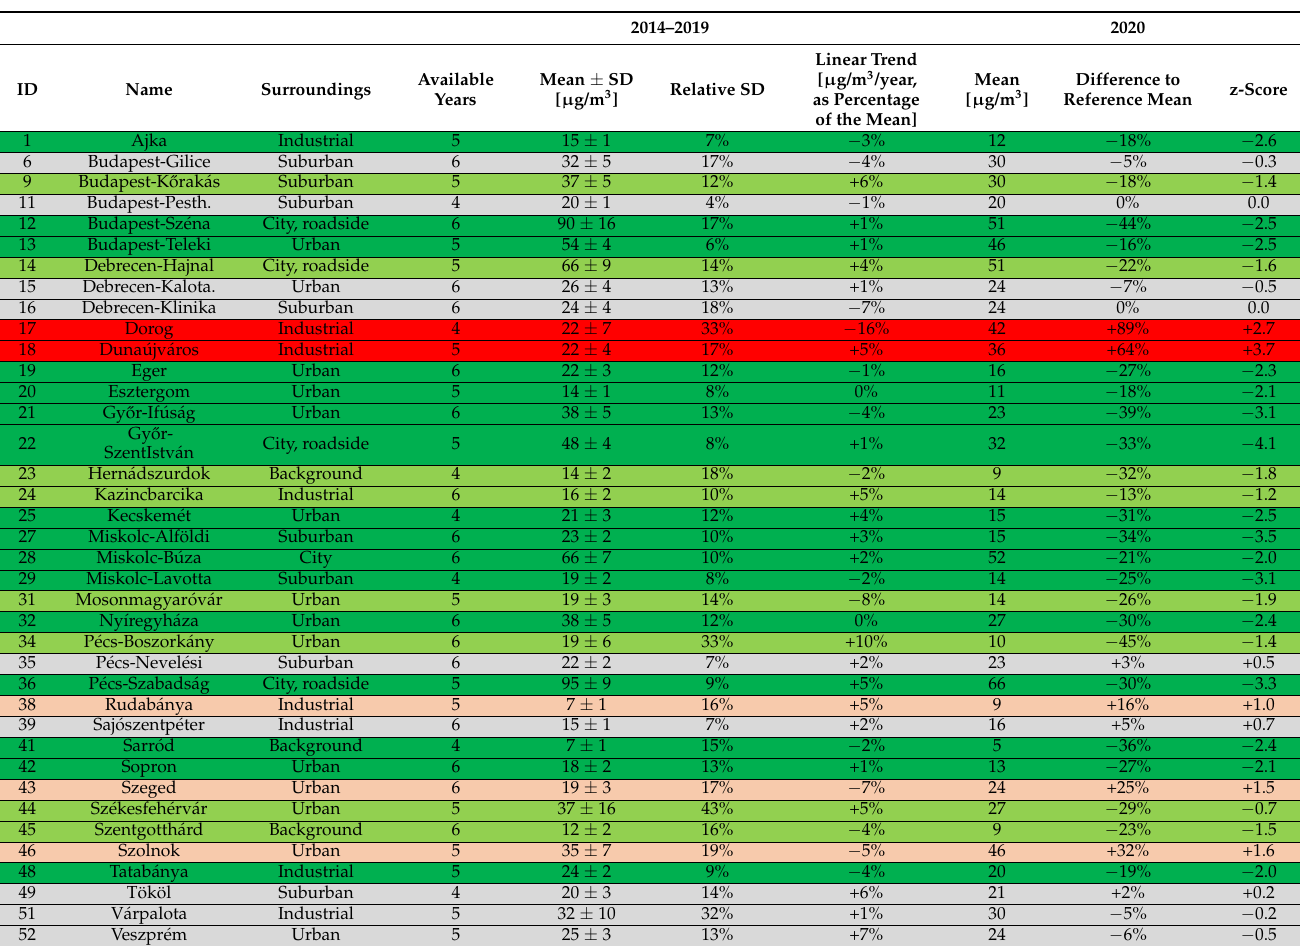
Table A2. Descriptive statistics and changes of NO x concentrations measured at Hungarian monitoring sites. Row colors: (light) red—z-score at least +1.96 (+0.67) and the difference to the reference mean is more than 3 year’s linear trend. (light) green—z-score less than − 1.96 ( − 0.67), and the difference to the reference mean is more than 3 year’s linear trend. Gray: absolute value of z-score less than 0.67 OR the difference to the reference mean is less than 3 year’s linear